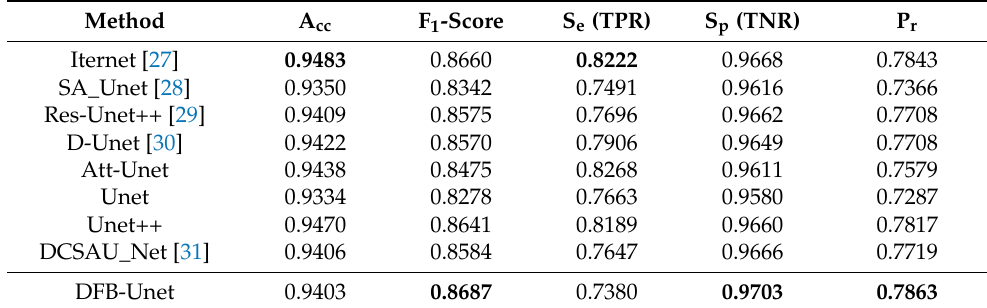
Table 5. Comparison of performance indicators on DRIVE